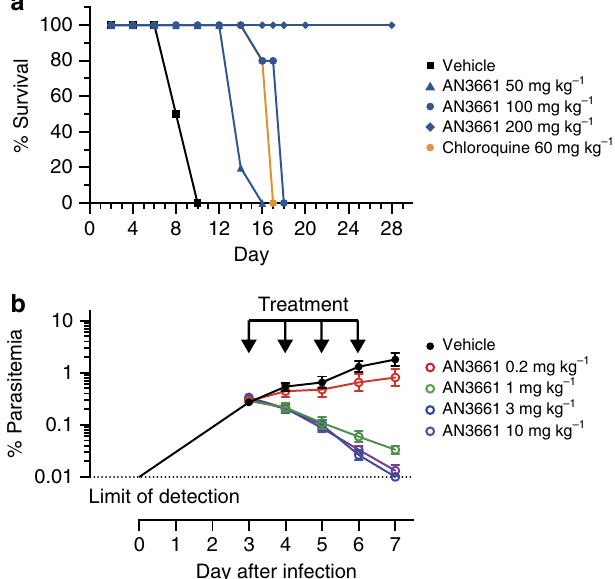
Figure 2 | AN3661 efficacy in murine malaria models ( a ) AN3661 efficacy